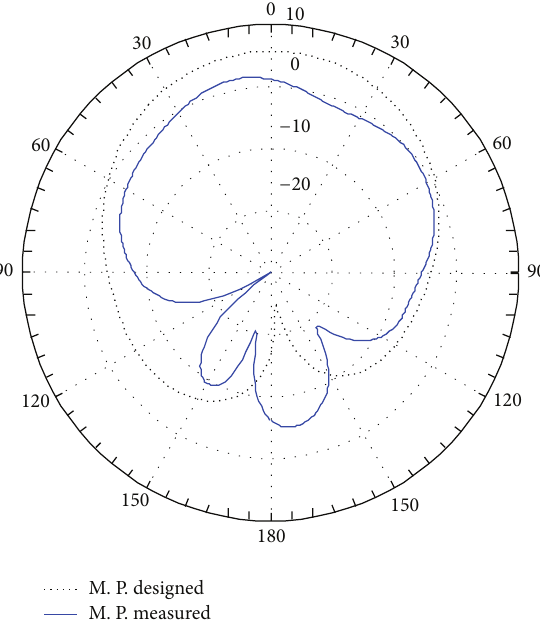
Figure 7: Simulation and measurement results for 𝐻 -plane gain of traditional patch with quarter-wave transformer (frequency: 5.38 GHz).